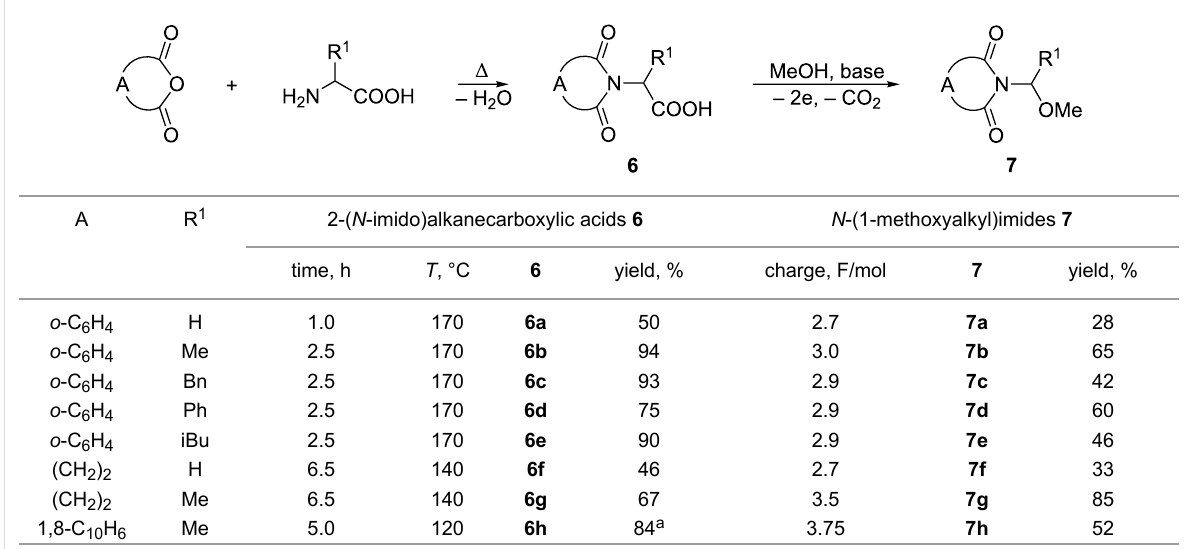
Table 1: Synthesis of 2-( N -imido)alkanecarboxylic acids 6 and N -(1-methoxy)alkylimides 7